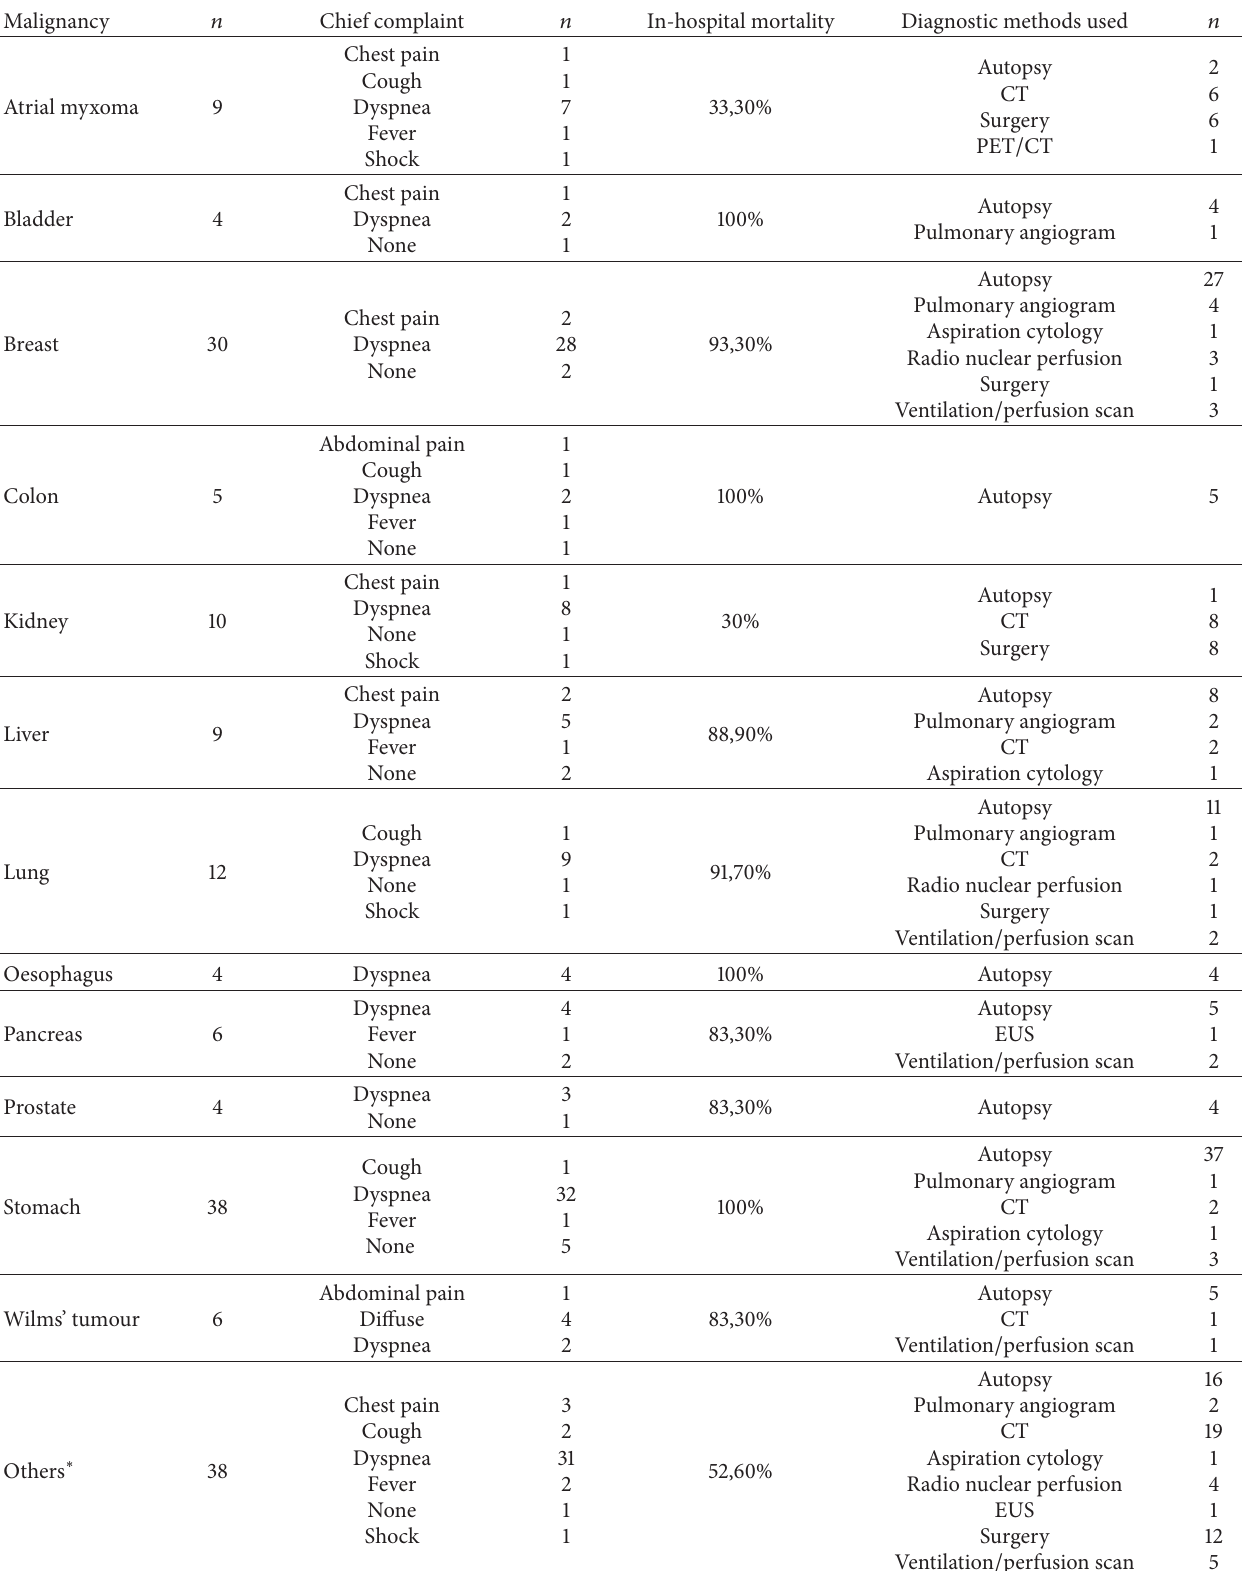
Table 1: Overview of reported pulmonary tumour